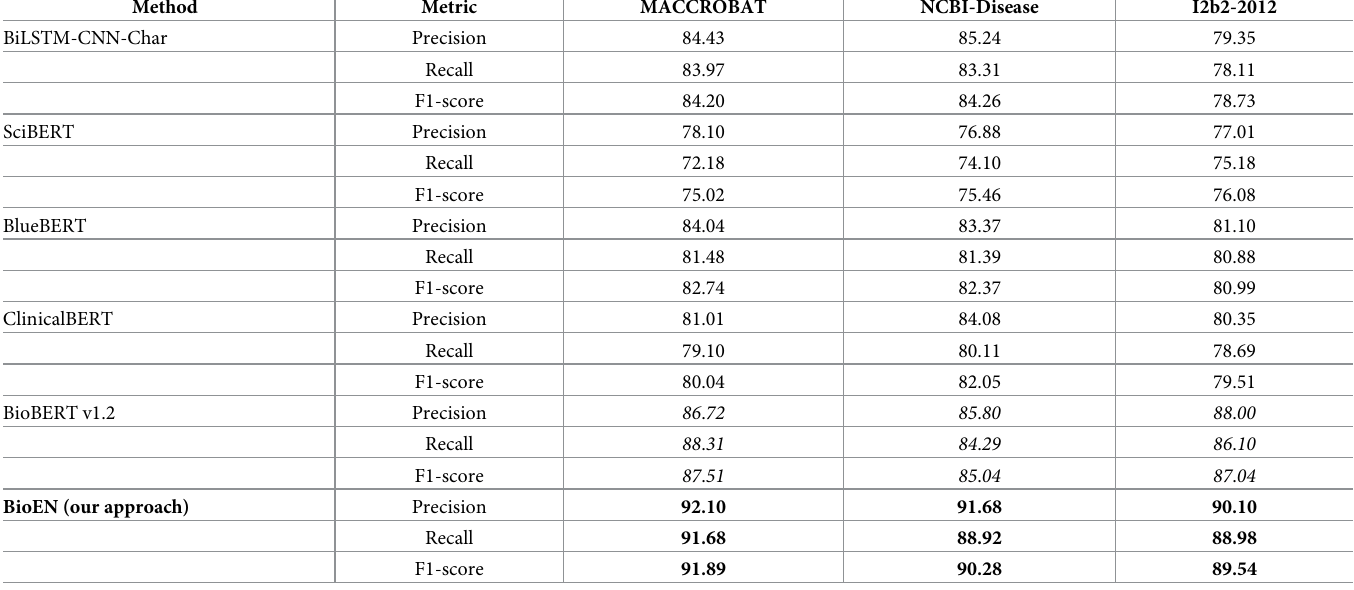
Table 4. Overall